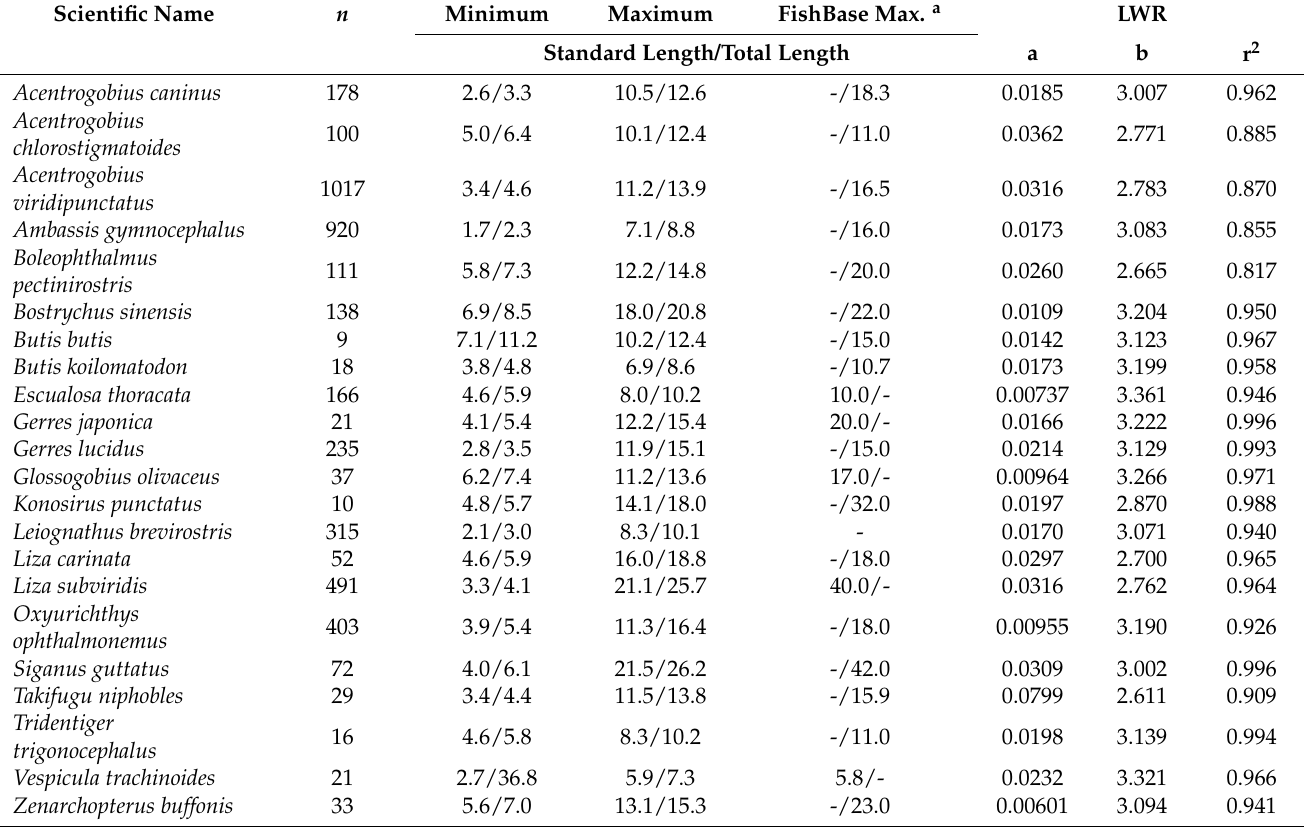
Table 1. Fish species sampled in the mangrove of the Dongzhaigang National Reserve, Hainan Province, China, and for which enough specimens (incl. relatively large ones) were measured for length–weight relationships (LWR) of the form W = a · L b to be calculated (for L = standard length). All the lengths are in centimeters; n = number of